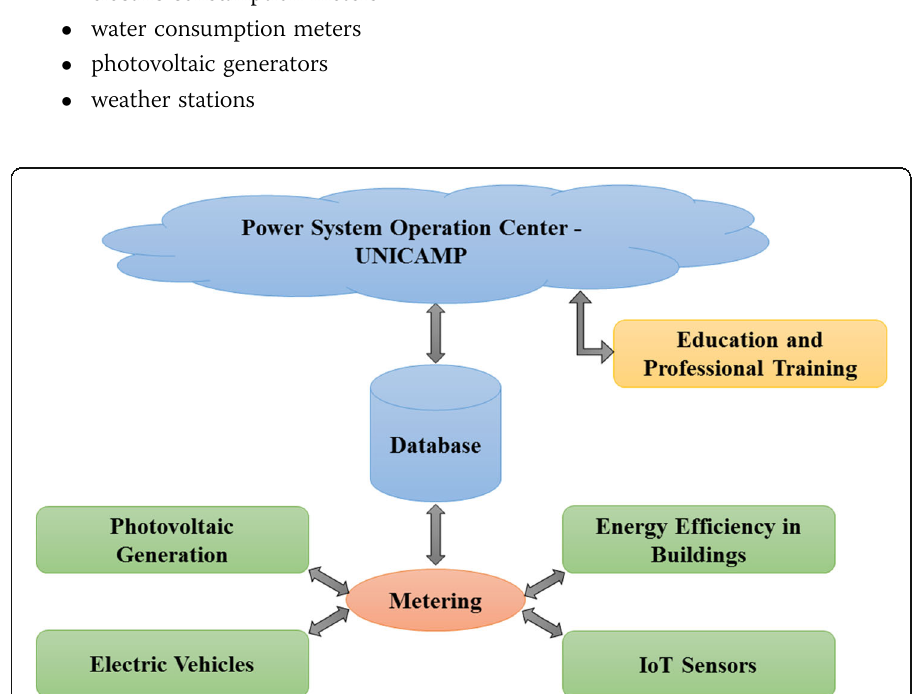
Fig. 2 Communication structure between